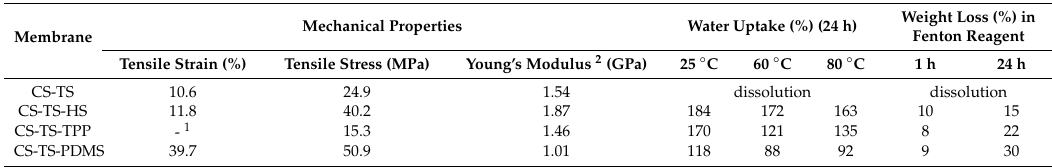
Figure 5. Mechanical stress–strain profiles at high and low (insert) tensile strain values of CS-TS ( 1 ), CS-TS-HS ( 2 ), CS-TS-TPP ( 3 ), and CS-TS-PDMS ( 4 ) composite membranes. Table 1. Mechanical properties, water uptake, and stability in oxidative environment and of chitosan-sulfonated titania composite membranes.